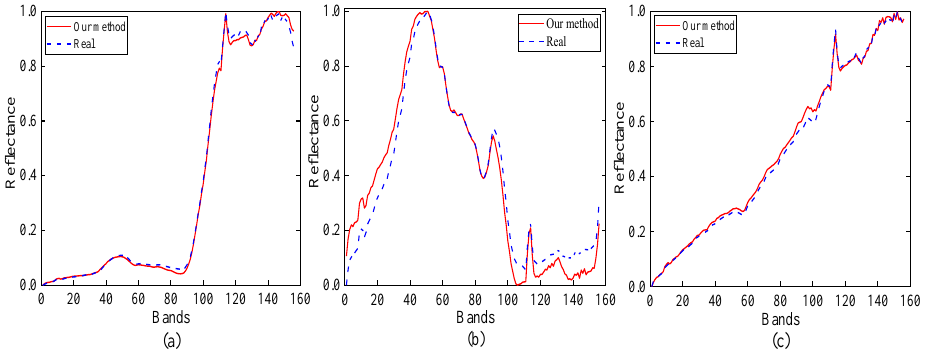
Figure 10. Reference signatures and estimated endmember signatures by our MDA-MVSA method from the Samson subimage: ( a ) tree; ( b ) water; and, ( c )